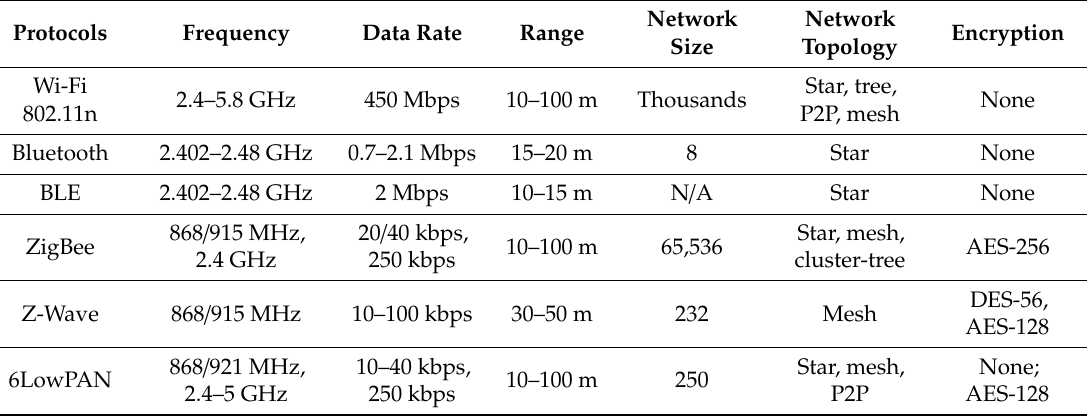
Table 2. Wireless communication protocols.